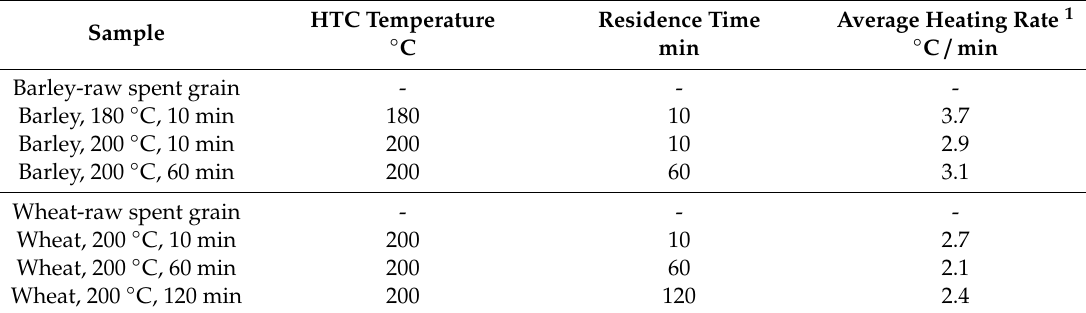
Figure 2. Diagram of the experimental hydrothermal carbonization (HTC) rig (1–Autoclave; 2–type K thermocouple; 3–PLC controller; 4–heating mantle, with band heaters; 5–draining; 6–dryer; 7–analysis of dry sample; 8–nitrogen for purging; 9–purging valve; 10–pressure relief valve). Table 1. Experimental matrix for the suite of hydrothermal carbonization experiments.